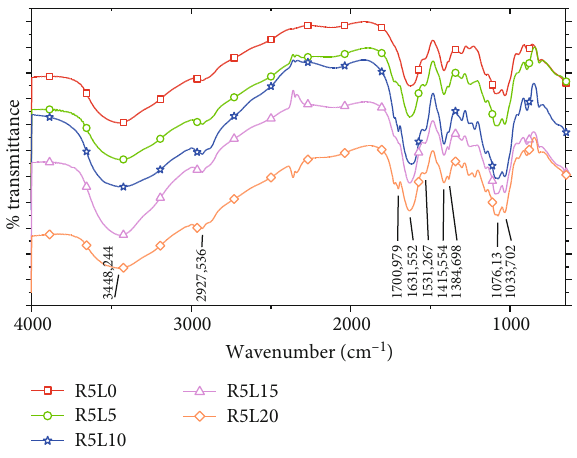
Figure 3: FTIR spectrum of NPB-R5Ly.